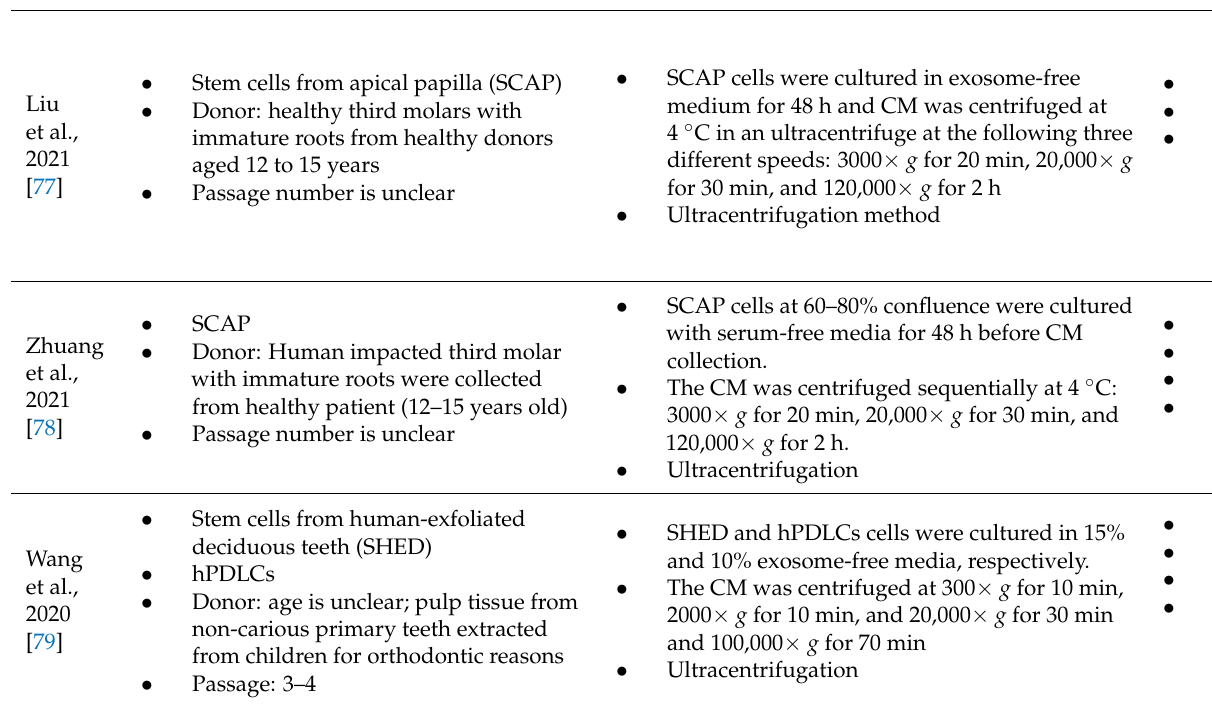
Key Characterization